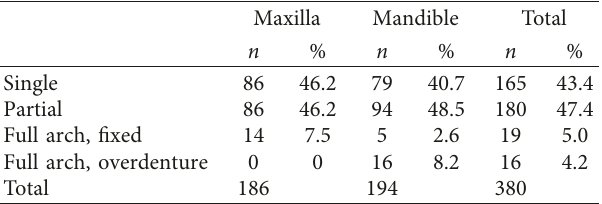
Figure 2: RFA measurement of an implant utilising a SmartPeg ™ transducer and an Osstell Mentor ™ machine (Osstell AB, Goth- enburg, Sweden). Table 4: Type of prosthetic constructions.